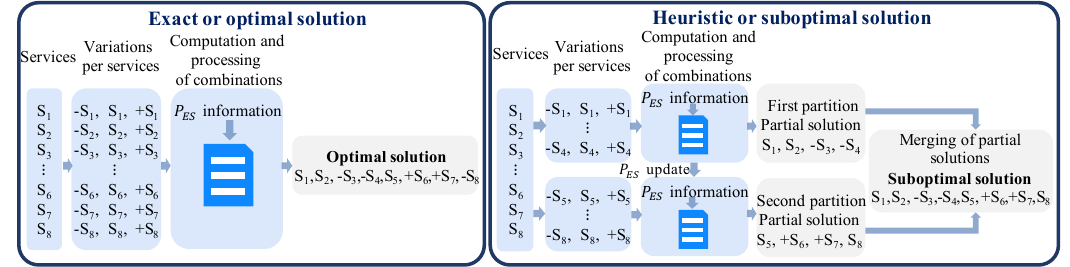
Figure 8. Overview of O PT T S and F AST T S strategies. Parameters: N = 8, T k s = 1, and numPart = 2 partitions for F AST T S .